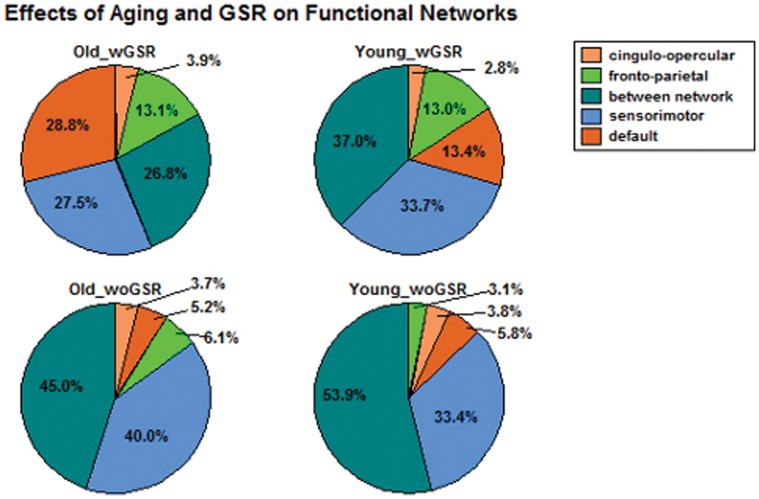
Effects of aging and GSR on brain functional networks.Pie chart illustrates the proportion of significant and reliable functional connections within each network. Binomial proportion tests showed aging was associated with significant decreases in reliable connections between-network but increases within sensorimotor and fronto-parietal networks. Each percentage number indicates the proportion of functional connections within corresponding networks.